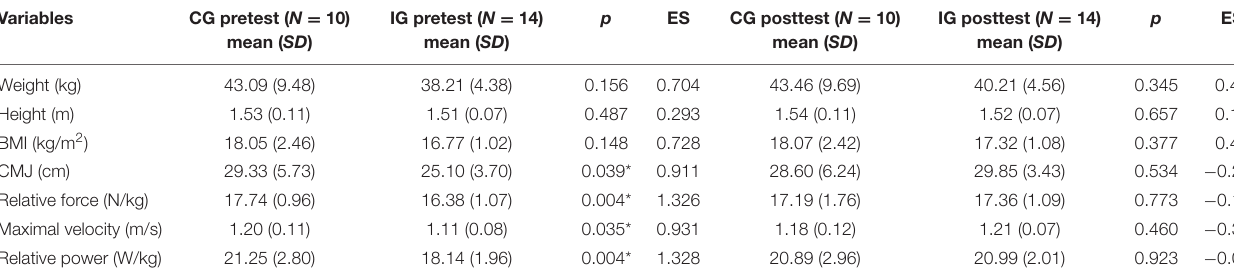
TABLE 2 | Intergroup comparison of jumping performance variables pre-post intervention.